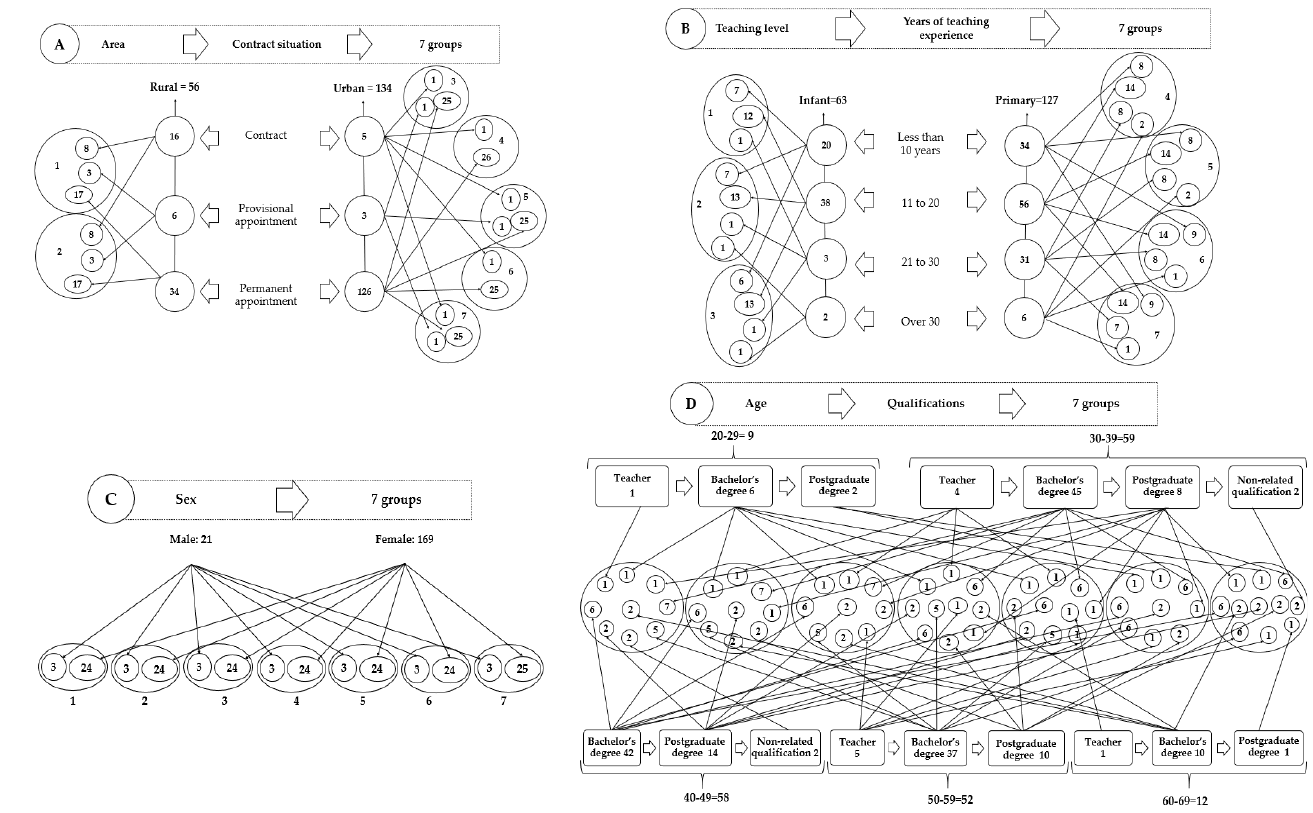
Figure 1. Group segmentation ( A – D ) used to carry out the programme. The numbers that were presented in each set of the model correspond to the number of teachers that were assigned to the different segments for the implementation of the program, and thus, the establishment of heterogeneous groups. Table 1. Session 1. Emotions: How much do I know and identify my